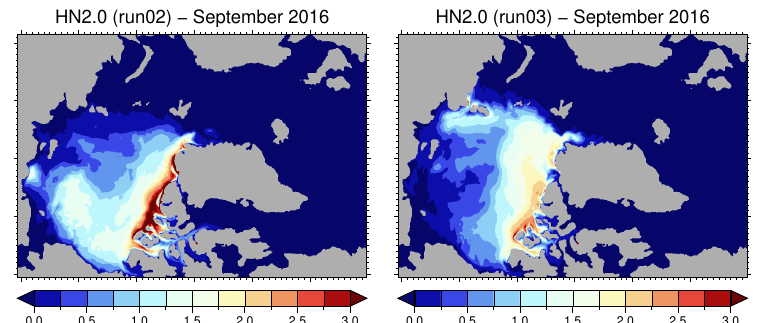
Figure 6. Mean sea-ice thickness (in meters) in September 2016 from two ensemble members, labeled as run02 ( left ) and run03 ( right ), of the ERAI-driven ensemble simulations with HN2.0, as an example for the coupled model’s ability to generate different sea-ice states under identical boundary conditions. Land areas of the T-grid are shown in